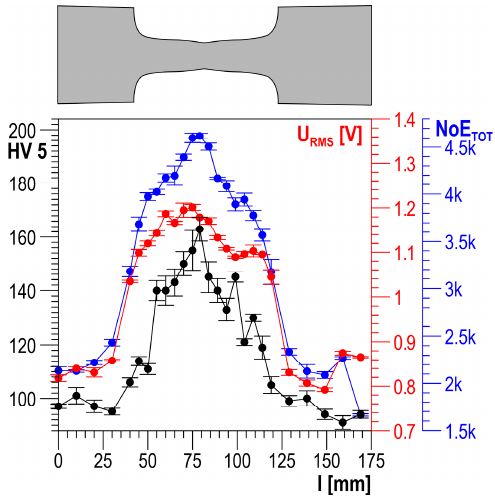
Figure 8. Distribution of HV5, RMS, and NoE TOT along the DC01 steel specimen length.